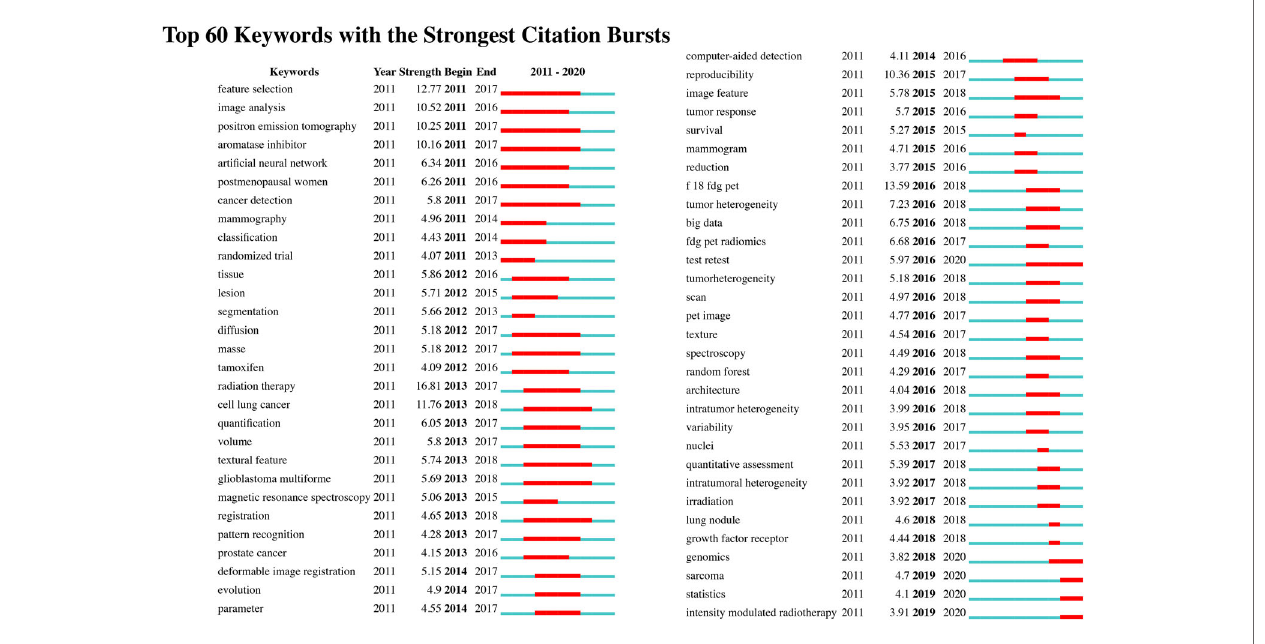
FIGURE 8 | Detection of top 60 keywords with the strongest citation bursts.